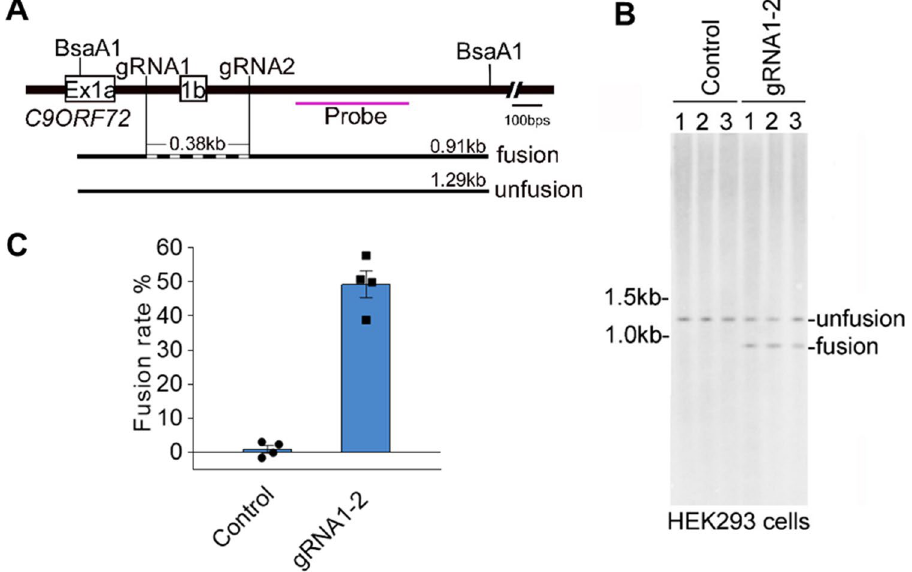
Figure 4. The fusion efficiency of gRNA1-2 editing sites in the HEK293 cells. ( A ) The experimental design for detecting the fusion efficiency by Southern blot. The BsaA1 enzyme was used to fragment the genomic DNA. The Southern blot probe was labeled in pink. ( B ) Genomic DNA from the HEK293 cells infected with control or gRNA1-2 lentivirus (Supplementary Fig. 2) was applied for the Southern blot. The fusion bands were present in the cells infected with gRNA1-2 but not in the controls from three biological replicates. ( C ) The fusion efficiency was estimated by the ratio of fusion to total (fusion + unfusion) band densities. Genomic DNA from 4 biological replicates. The values are presented as mean ± SEM ( n =